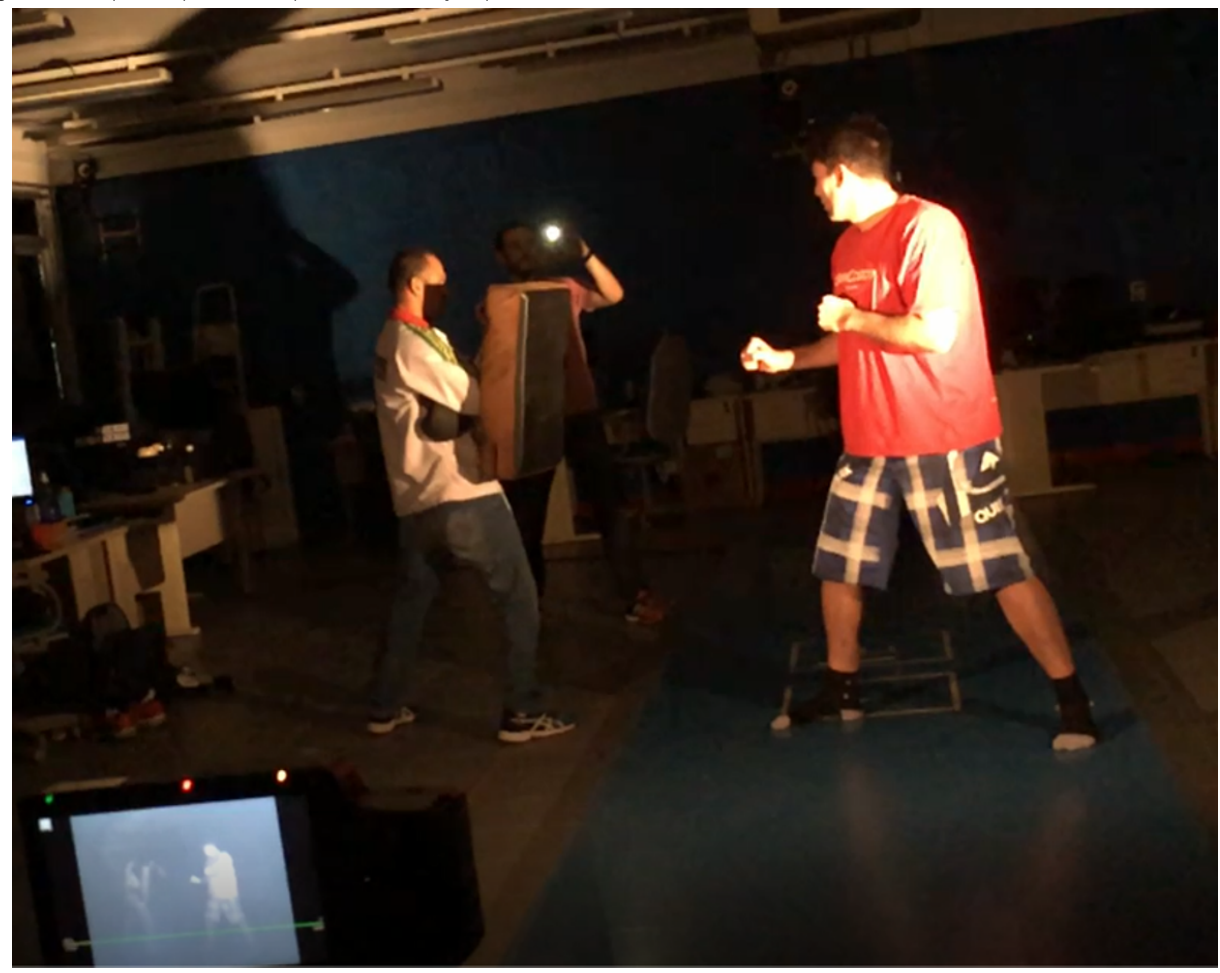
Figure 2. Set up of the protocol test position to identify response time of the